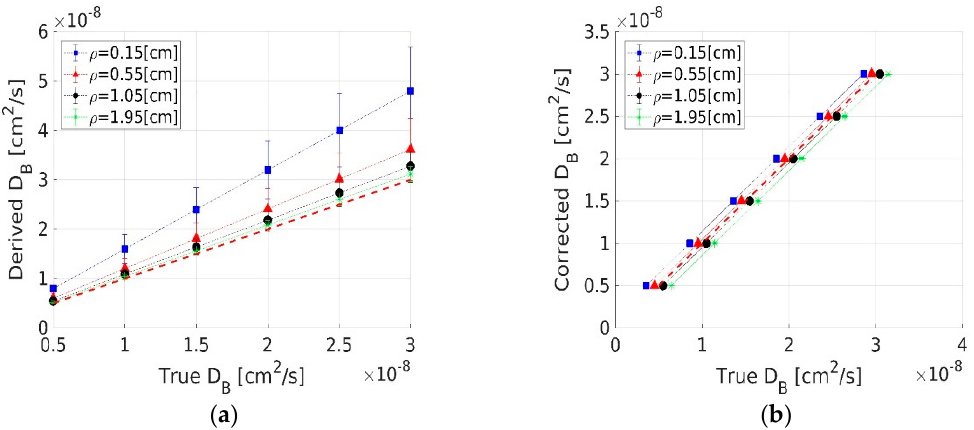
Figure 8. Estimated Brownian flow coe ffi cients vs. simulated values. ( a ) shows the coe ffi cients obtained directly by fitting simulated data, where each line shows data for di ff erent SDS. Symbols were average values obtained from 35 simulated media having fixed D B (but changing optical properties); errorbars show standard deviations. ( b ) shows the same data in ( a ) after appropriate scaling by correction factors (see text). The errorbars in ( b ) are smaller than the size of symbols shown and di ff erent lines (for di ff erent SDS) are shown staggered only for clarity. The dashed line in Figure 8a,b shows y = x